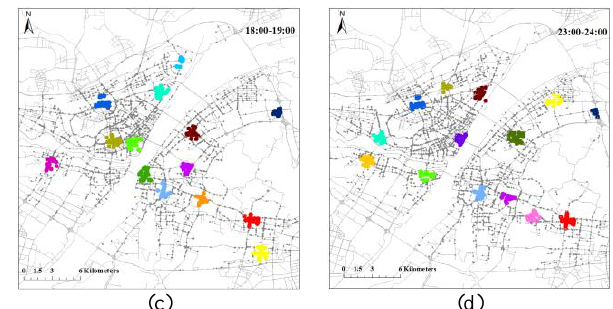
Figure 5. Hotspots on weekday (May 7 th , 2014).